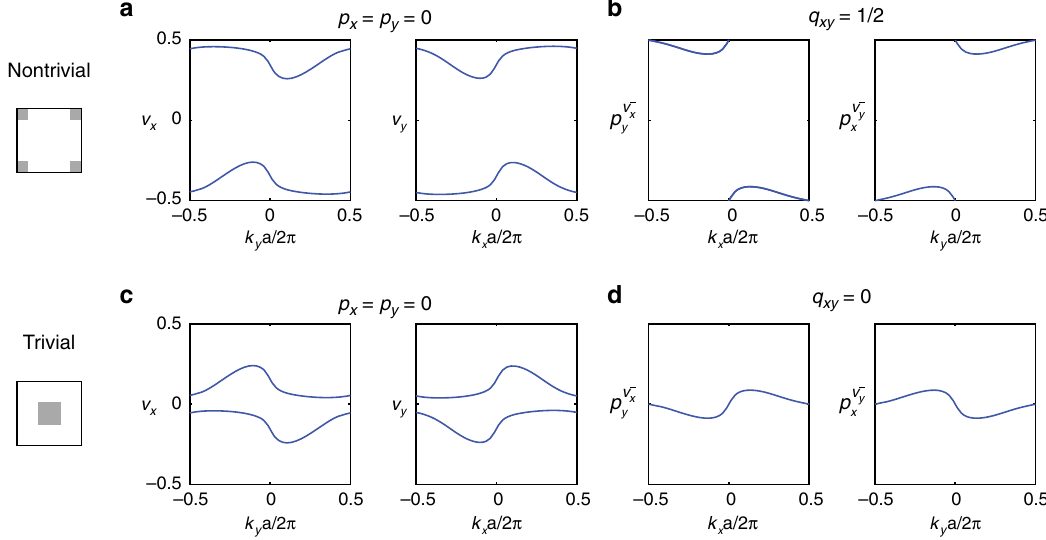
Fig. 2 Con fi rmation of quadrupole and trivial PhCs through nested Wannier bands. a Wannier bands, ν x ( k y ) and ν y ( k x ), are calculated for the fi rst and second bands of the quadrupole PhC. Results show the bulk dipole momentum is zero ( p x = p y = 0). b Calculations of the nested Wilson loops, p ν (cid:2) x y ¼ p ν (cid:2) y x ¼ 0 : 5, show the bulk quadrupole momentum q xy is non-trivial and quantized to 0.5. c , d Similar calculations repeated for a trivial PhC, showing ν (cid:2) y zero bulk dipole moments ( p x = p y = 0) and zero quadrupole moments ( p ν (cid:2) x y ¼ p x ¼